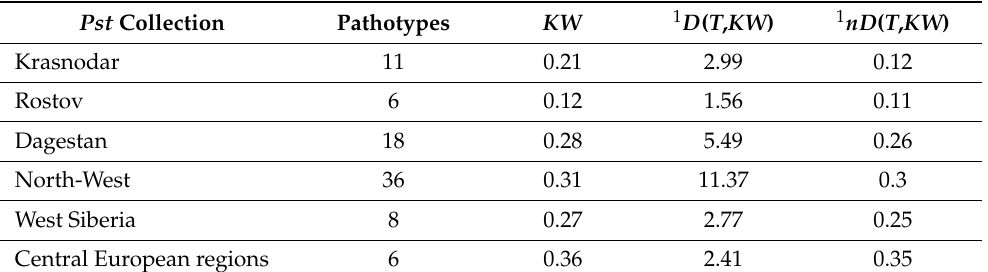
Table 5. Variability within Puccinia striiformis populations sampled from common wheat in Russian